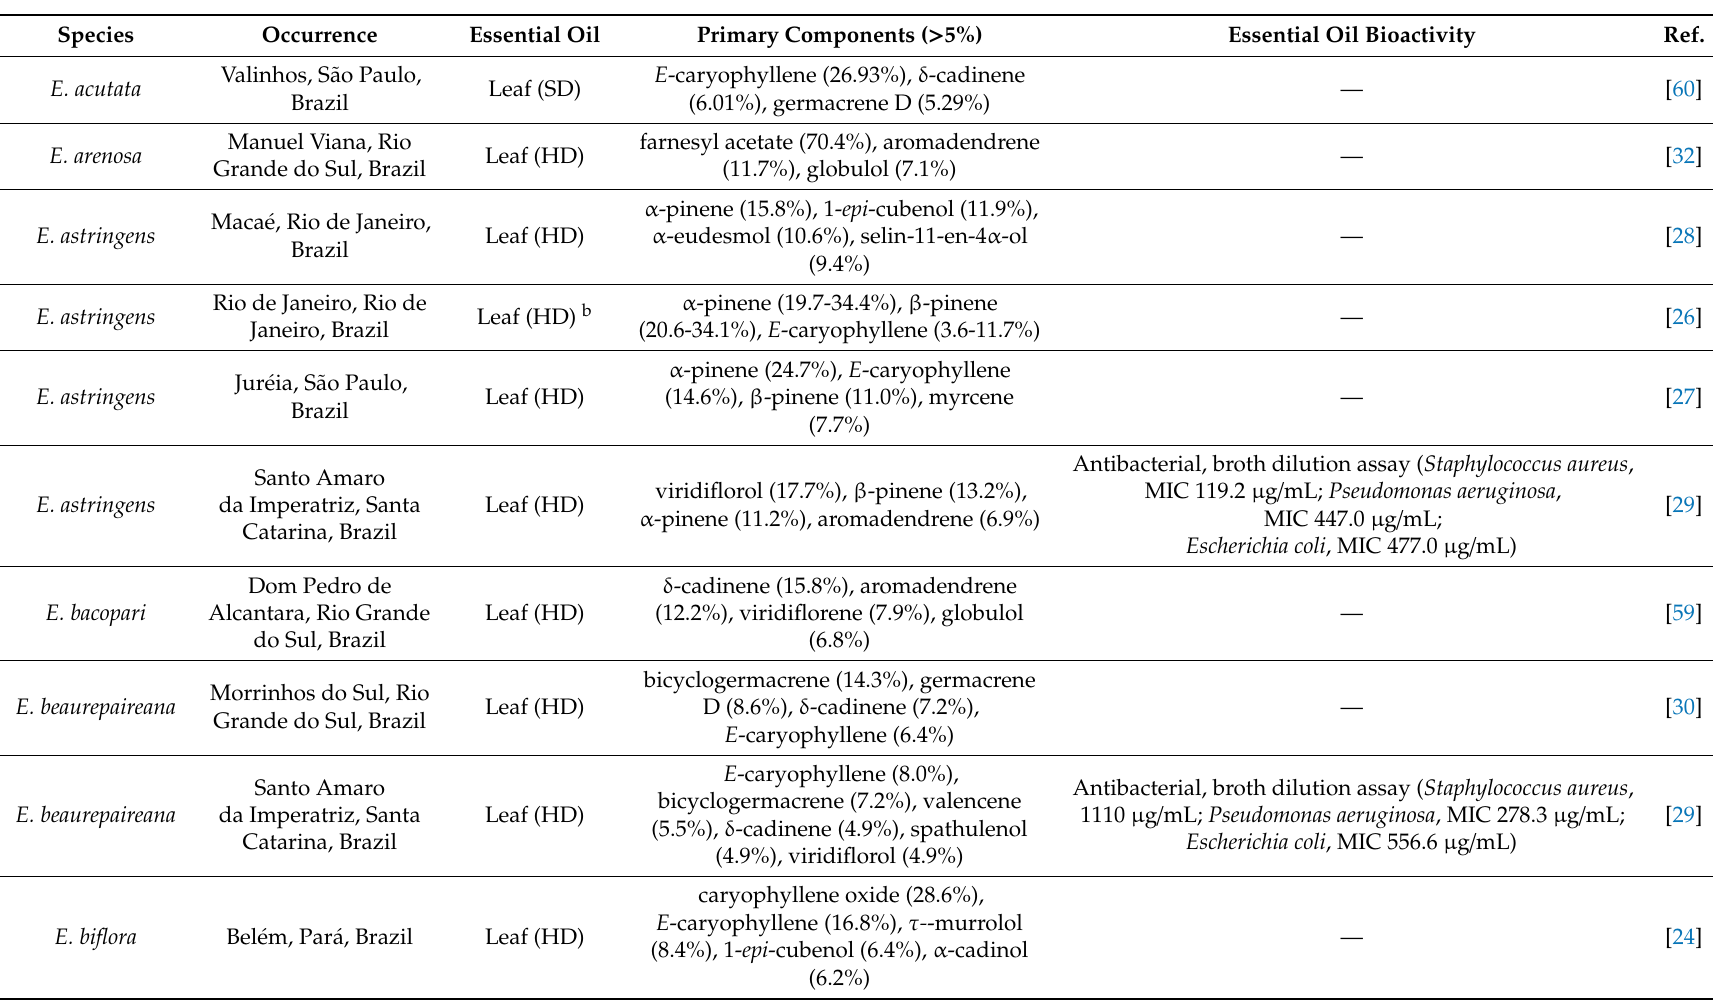
Table A1. Species of Eugenia and Syzygium in South America: essential oil composition and biological activity.